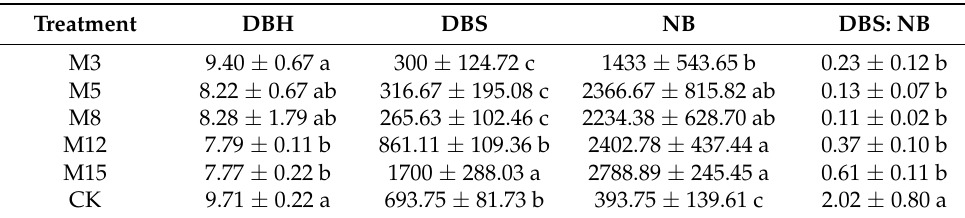
Table 1. Stand characteristics for moso bamboo in strip cutting (M3, M5, M8, M12, and M15) or unharvested (CK)